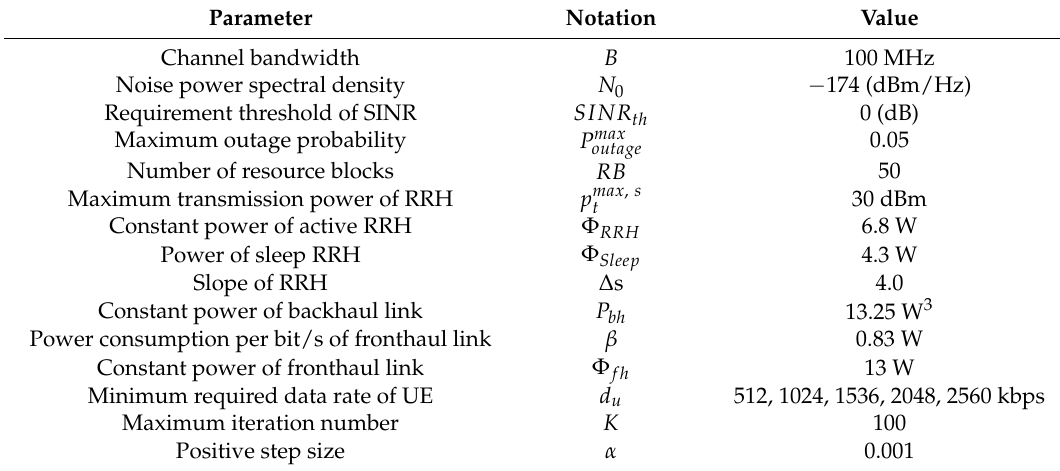
Table 1. Simulation